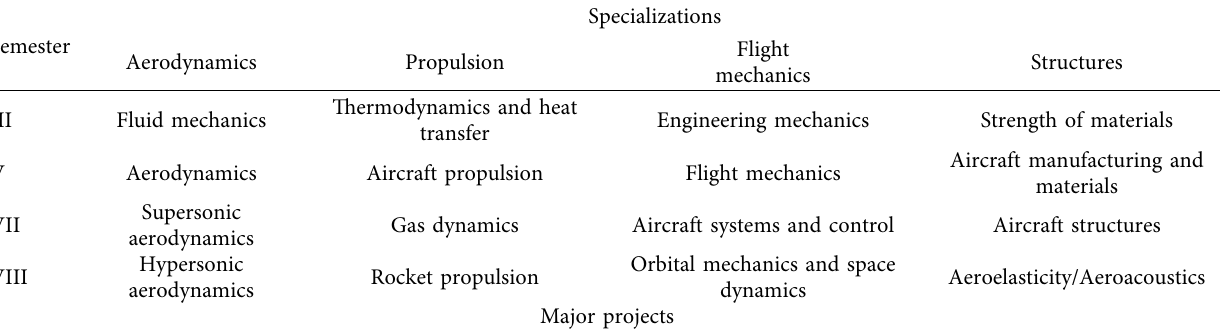
Table 1: Semester-wise specialization for aerospace